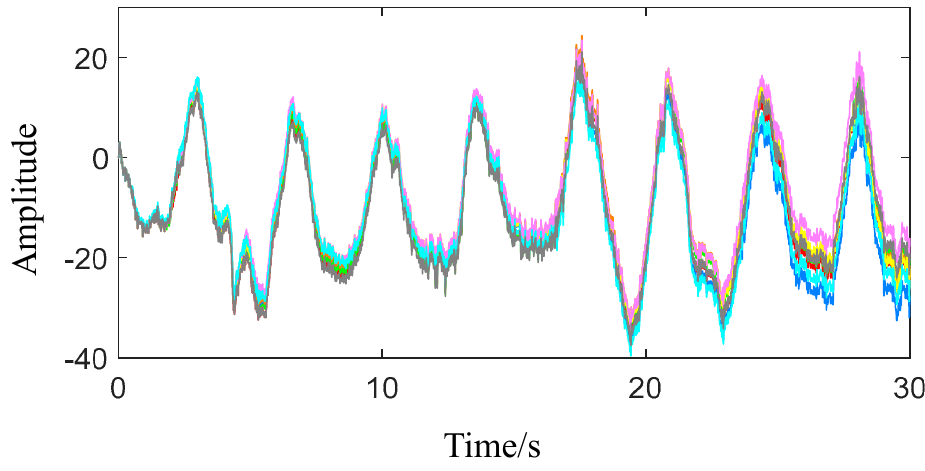
Figure 4. Results of 8 times strong physical sign extraction.